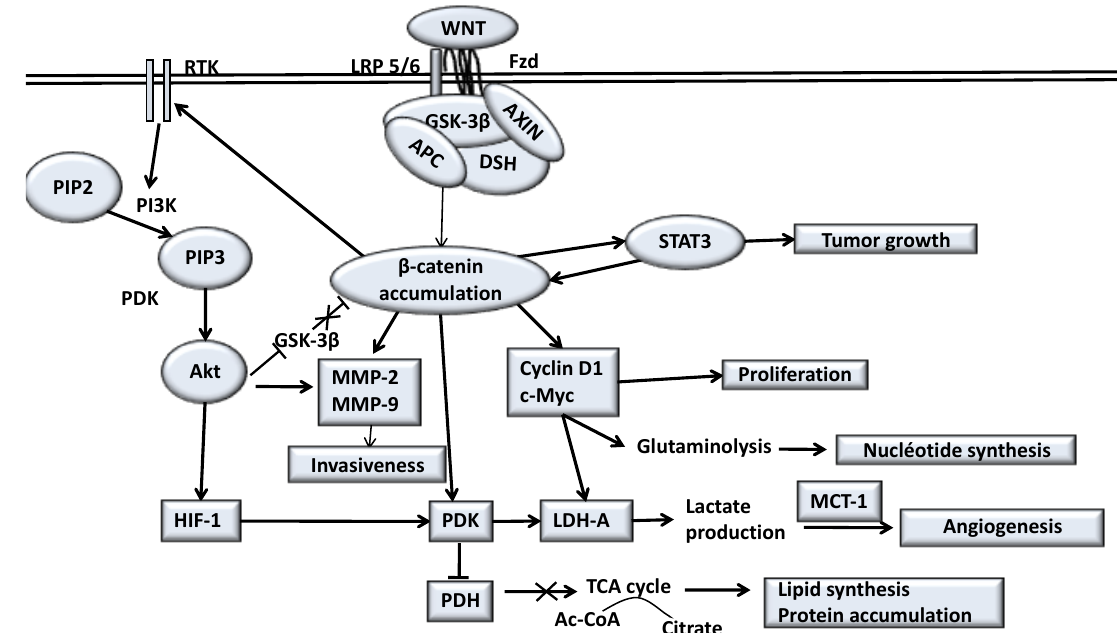
Figure 1. The WNT/ β -catenin pathway and its different actions in gliomas processes. When the canonical WNT/ β -catenin pathway is stimulated, STAT3 signaling pathway upregulates the expression and transcriptional activity of β -catenin. In cancers STAT3 is a tumor aggressiveness factor. In cancers, the overexpression of EGFR (a receptor tyrosine kinase: RTK) stimulates PI3K/Akt pathway. PI3K/Akt signaling leads to the phosphorylation of GSK-3 β that leads to nuclear translocation and stabilization of β -catenin. Similarly, WNT/ β -catenin pathway stimulates EGFR in gliomas. Akt signaling increases MMP-2 and MMP-9 activity, which induce invasion of cancer cells. Akt signaling induces HIF-1a, which stimulates PDK1. Overexpression of WNT/ β -catenin also stimulates PDK1. PDK1 and c-Myc induce LDH-A, and cytolsolic pyruvate is shunted into lactate through activation of LDH-A. Overexpression of MCT-1 exports lactate to extracellular space. Lactate production stimulates angiogenesis. c-Myc induced glutaminolysis supports mitochondrial integrity and production of aspartate, and results in nucleotide biosynthesis. c-Myc and cyclin D stimulate proliferation of gliomas.